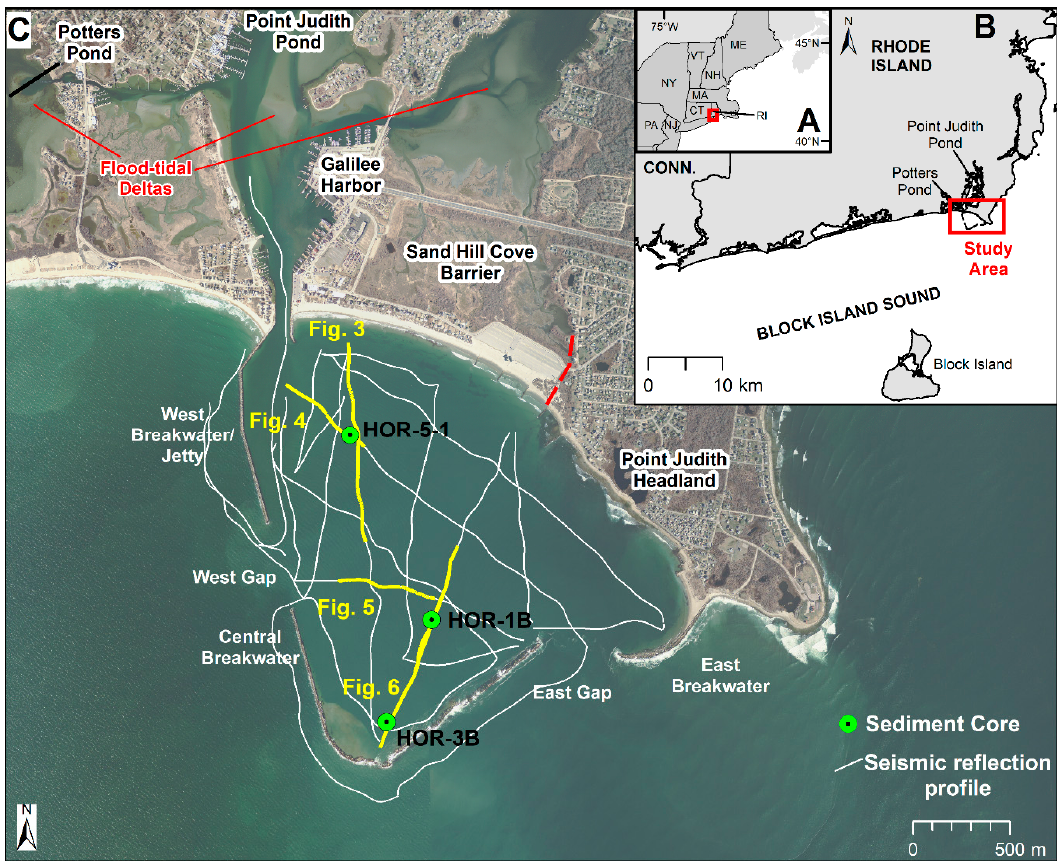
Figure 1. ( A ) Locus map of southern New England showing the location of the study area. ( B ) Location of the Point Judith Harbor of Refuge (HoR) relative to the rest of the Rhode Island South Shore. ( C ) 2014 orthophotograph of the HoR. White lines are the extent of 2016 and 2017 seismic reflection profiles. Yellow lines show the location of the seismic reflection profiles seen in Figures 4–7. Dashed red line shows the approximate boundary between the Sand Hill Cove Barrier and Point Judith Headland. Green circles show the location of sediment cores discussed in the text. Note the sand accumulations within Point Judith Pond and Potters Pond which represent flood-tidal delta deposition.